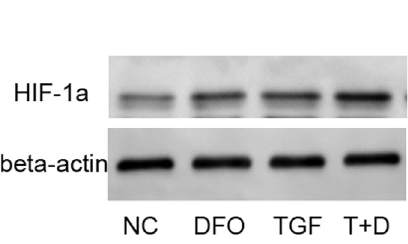
Figure 4 - HIF-1 (cid:6) mediates the synergistic effect of DFO in TGF- (cid:15) 1-triggered chondrogenesis in ATDC5 cells. The cells were treated with TGF- (cid:15) 1 (TGF or T; 10 ng/mL), 100 (cid:3) M DFO (D) or both for 1 h and then lysedtoobtaincytosolicproteinsforwesternblotting. (cid:15) -Actinwasusedas